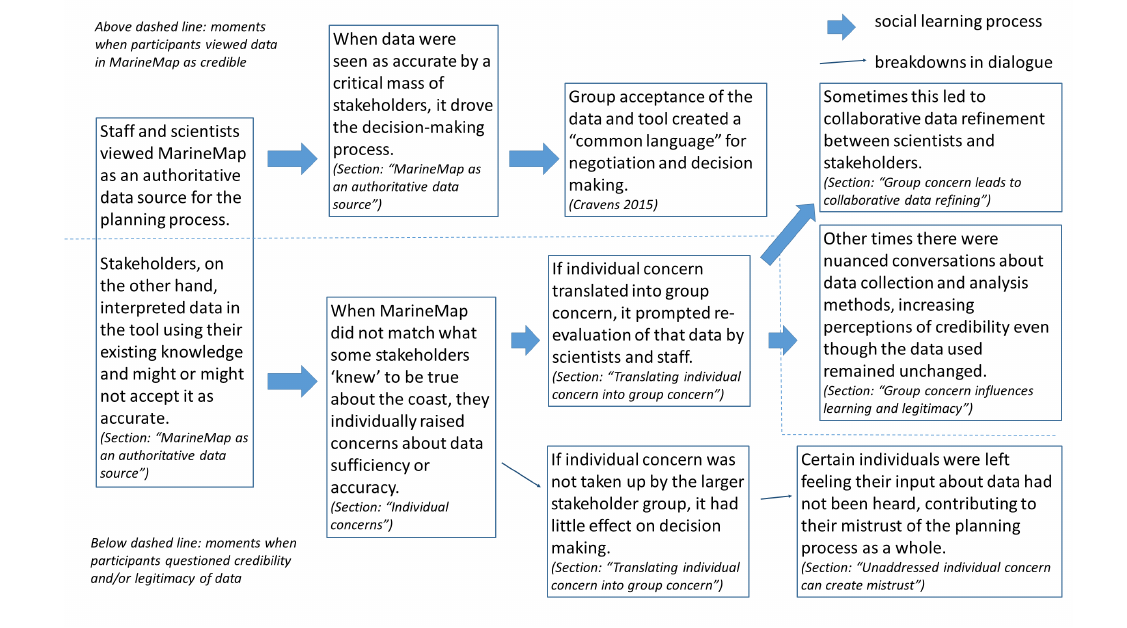
Fig. 3 . Paths to social learning about data in the Marine Life Protection Act (MLPA)